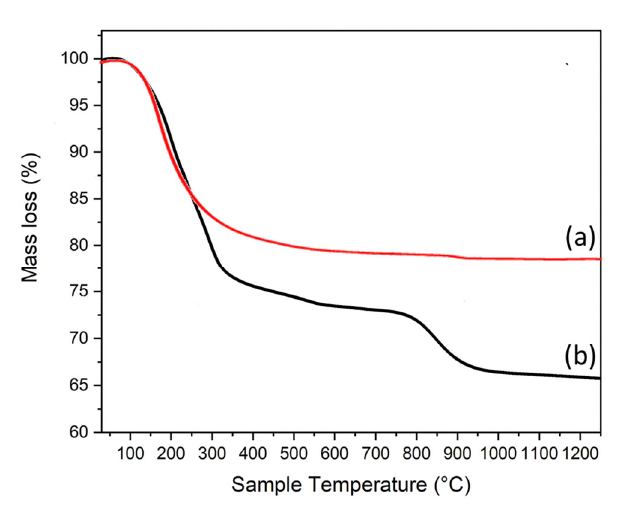
Figure 3. TGA curves for allophane ( a ) and for ZnAl-SO 4 LDH ( b ).